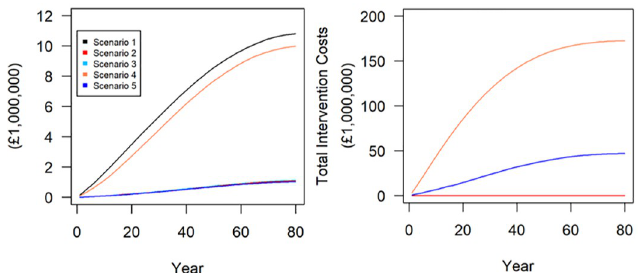
Fig 6. Results. Lifelong simulations of Covid-19 effects on total healthcare costs (a) and total intervention costs (b) following policy intervention scenarios. Scenario 1 is a baseline (no interventions); Scenario 2 is targeted vaccinations programme by age; Scenario 3 is targeted vaccinations by ‘clinically vulnerable’ risk group; Scenario 4 is periodic lockdowns; Scenario 5 is periodic lockdowns with whole population vaccination programme. Outputs represent the annual mean values of 100 simulation runs in a cohort of 1,000 agents.